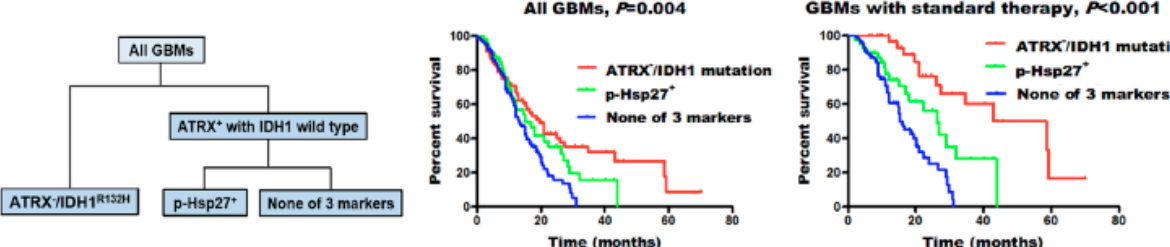
Figure 2. Molecular classification of glioblastomas (GBMs). GBMs were separated into three groups: ATRX − /IDH1R132H, high p-Hsp27 expression (p-Hsp27+), and none of these three markers. Indi- viduals with ATRX − /IDH1R132H showed the longest median survival, those with high p-Hsp27 expression had an intermediate prognosis, and those without any alteration in the three proteins had the poorest survival rates [53].